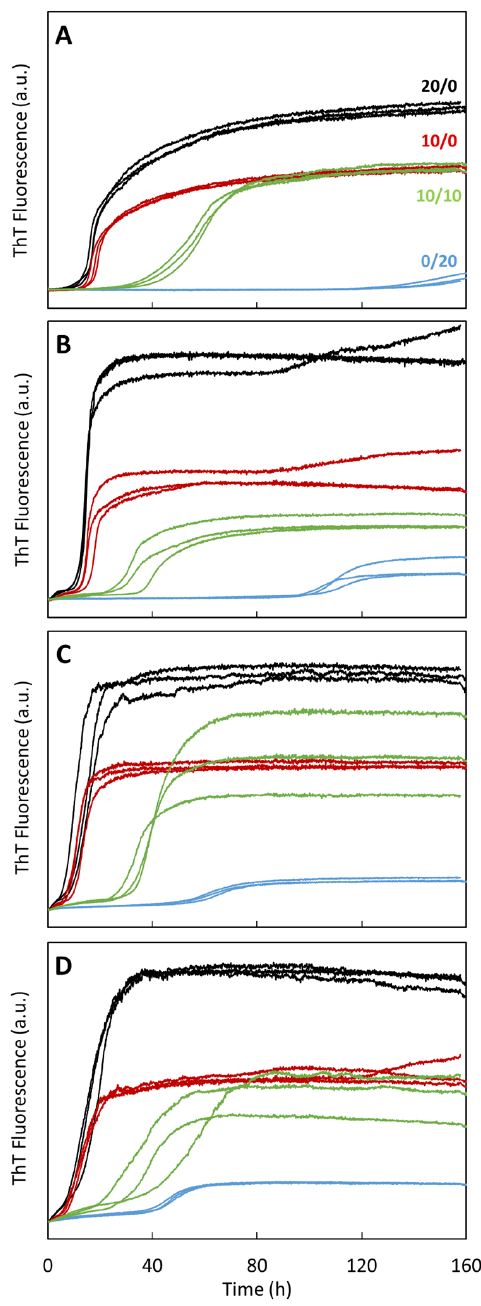
Figure 3. Kinetic monitoring of A β 1–40 and ox A β 1–40 co-assembly using ThT fluorescence as a function of pH. Curves are shown as triplicate. [A β 1–40 ] = 20 µM (black); [ ox A β 1–40 ] = 20 µM (blue); [A β 1–40 ] = [ ox A β 1–40 ] = 10 µM (green) and [A β 1–40 ] = 10 µM (red). pH 7.4 ( A ), 7.0 ( B ), 6.5 ( C ) and 6.0 ( D ). From experiment N°1: Hepes buffer 50 mM, [NaCl] = 65 mM. Y-axis corresponds to ThT fluorescence in arbitrary unit (a.u.); data are directly comparable between them (same y-scale).